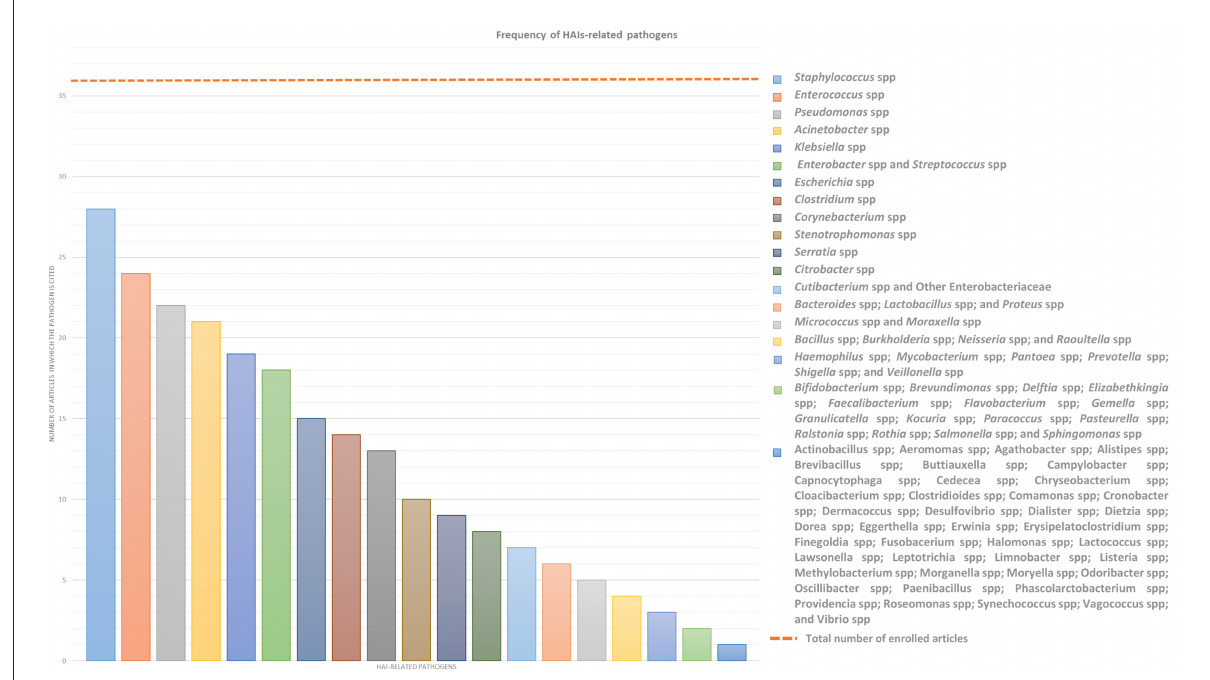
FIGURE2 Frequency of HAIs-related pathogens. In the graph are represented the number of article out of the 36 enrolled which treated each specific pathogen to better highlight which of them result most prevalent. ESKAPE bacteria, namely Enterococcus spp, Staphylococcus spp, Klebsiella spp, Acinetobacter spp, Pseudomonas spp, and Enterobacteriaceae such as Enterobacter spp and Escherichia spp, in addition to Streptococcus spp and Clostridium spp resulted the most infective pathogens which should be controlled to prevent